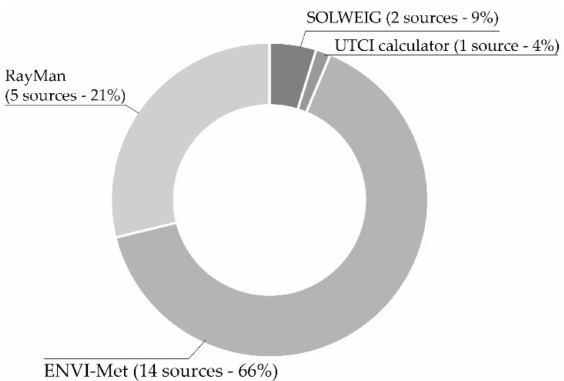
Figure 3. The most used software and tools outlined from the literature